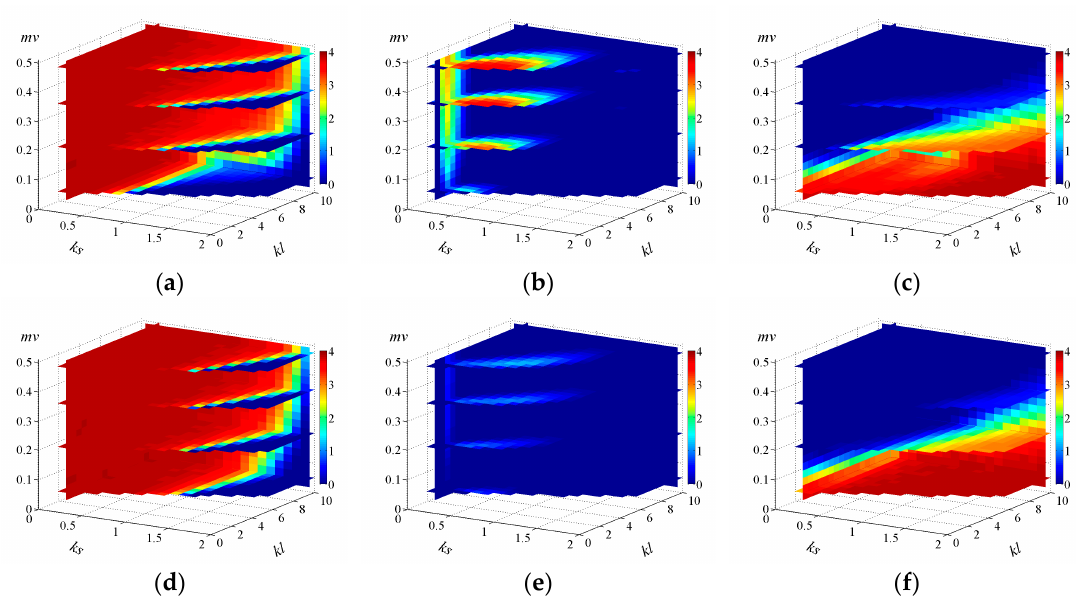
Figure 6. SE response to rough surface when varying: ( a , d ) ks ; ( b , e ) ; and ( c , f ) m v at a polarization of: ( a – c ) VV; and ( d – f ) HH. The incident angle is 45 ◦ and the frequency is 1.26 GHz. Normal distribution disturbances were added to the input parameters, with σ equal to 1% of the maximum of the corresponding surface parameters. As an example, σ is set to 0.02, 0.1, and 0.005 m 3 m − 3 when varying: ( a , d ) ks ; ( b , e ) kl ; and ( c , f ) m v , respectively.